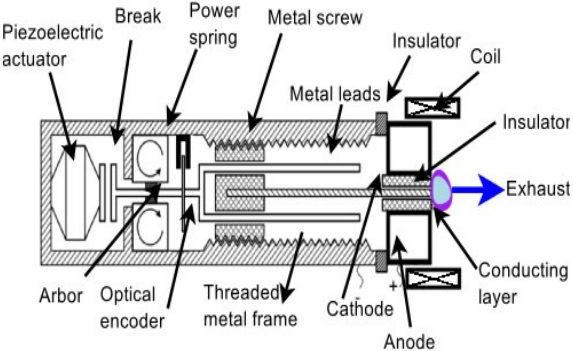
Figure 2. Schematics of the ISF-VAT with added magnetic air